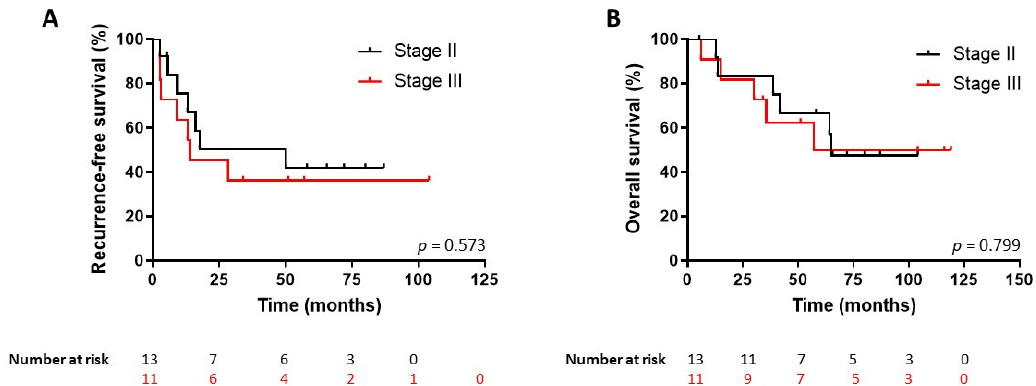
Figure 6. Kaplan–Meier survival analysis according to European Network for the Study of Adrenal Tumors (ENSAT) stage II and stage III (24 patients). No significant differences were observed between ENSAT stage II and stage III for Recurrence-free survival ( A ) or Overall survival ( B ) predictions in this cohort.